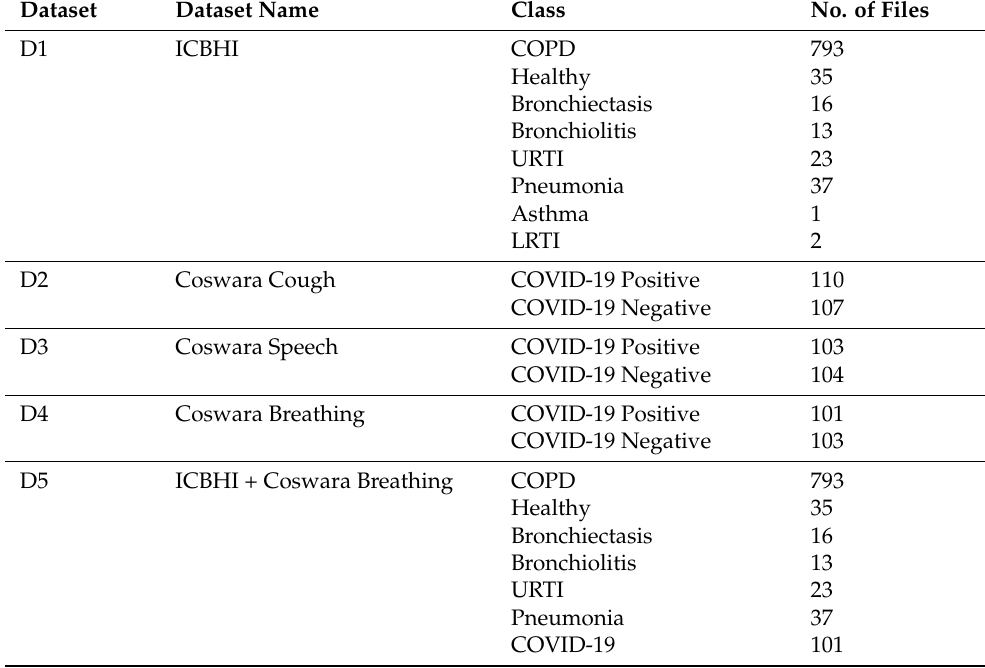
Table 2. Dataset properties.